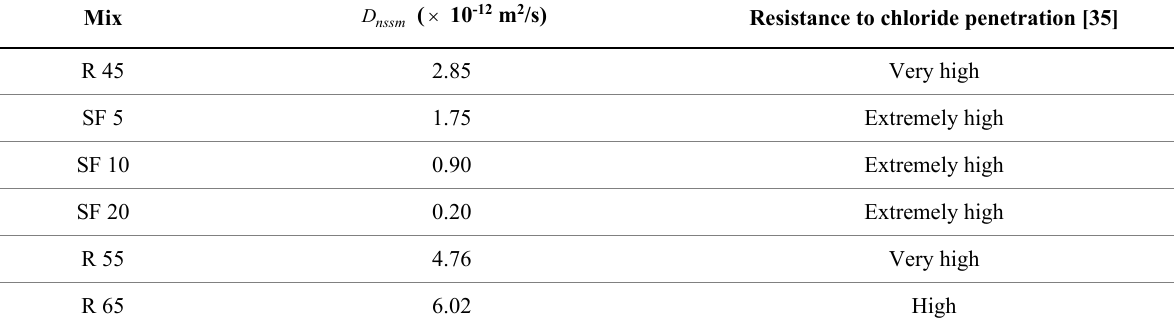
) obtained through NT Build 492 [12] test nssm D